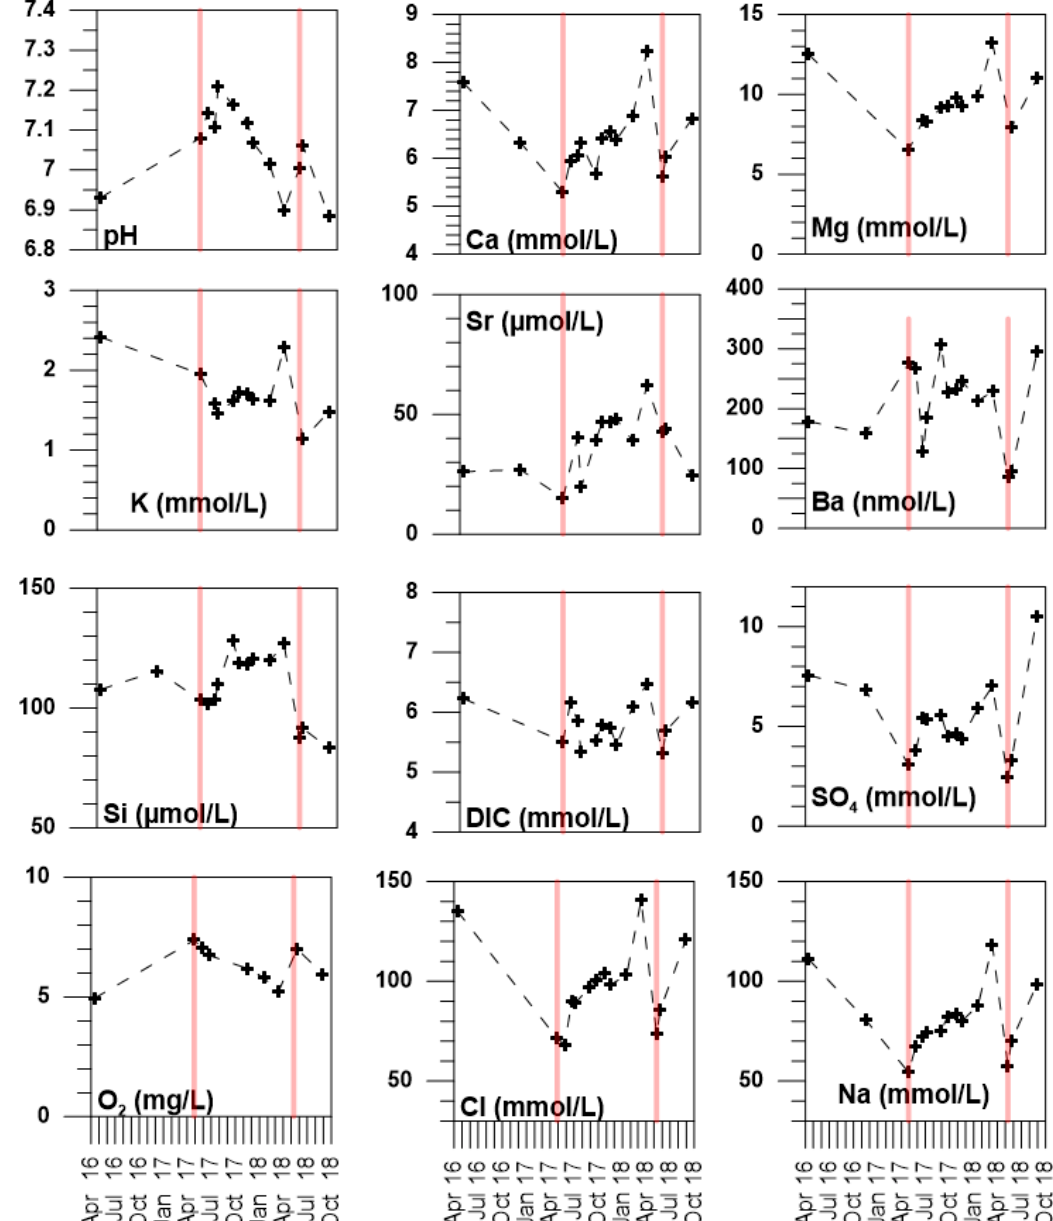
Figure 3. Variation with time of pH, ORP and the element concentrations of the La Palme Lavoir karstic spring. The vertical red lines highlight the dates of the minima in salinity (S = 4.8 on April 28, 2017 and S = 4.7 on May 11, 2018).